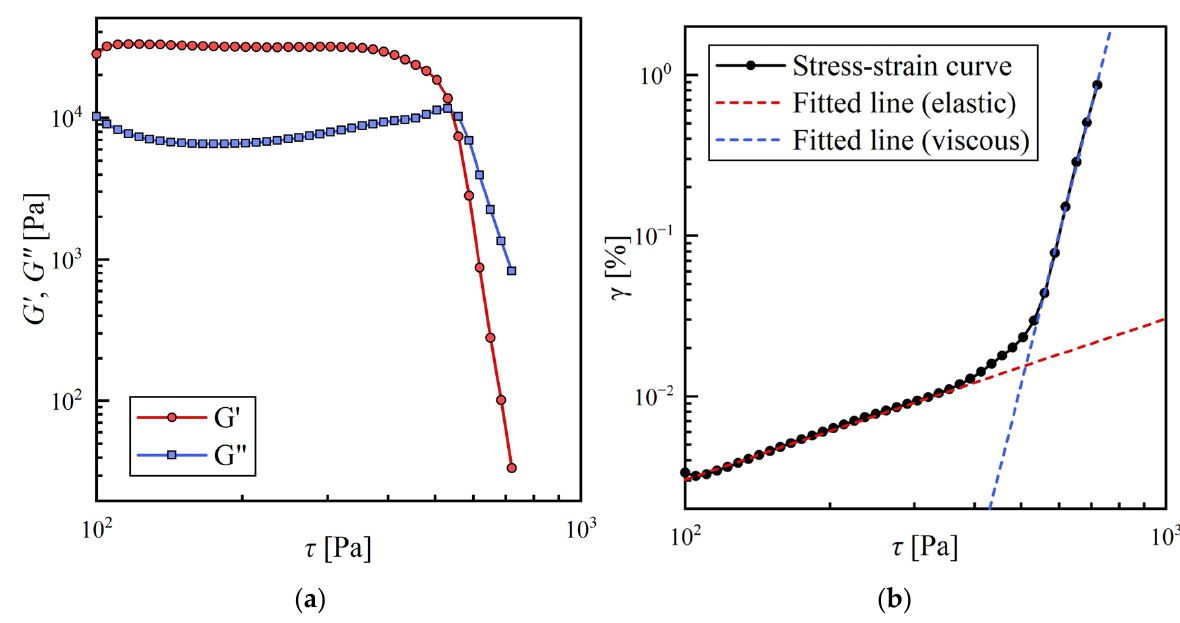
Figure 2. The result of oscillation stress sweep measurements of a 12HSA organogel prepared with styrene ( 𝑤 = 1.10%) : ( a ) Storage and loss moduli with various stress; ( b ) Stress/strain curve.